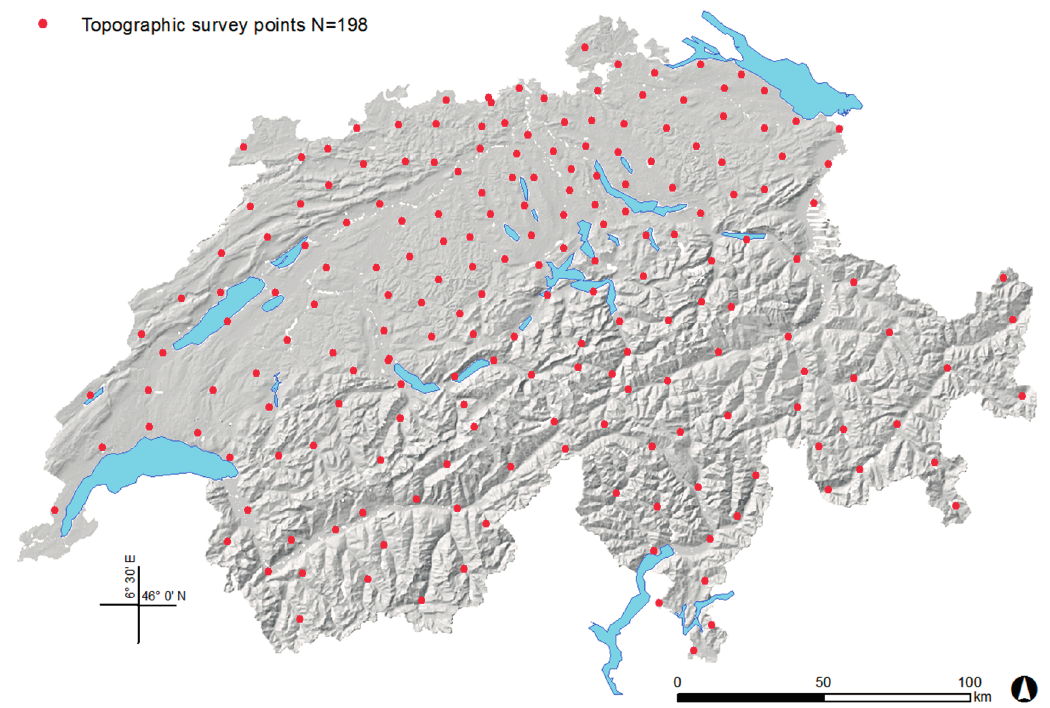
Figure 4. Reference data for accuracy assessment. The 198 topographic survey points of the national triangulation network were used for an independent error